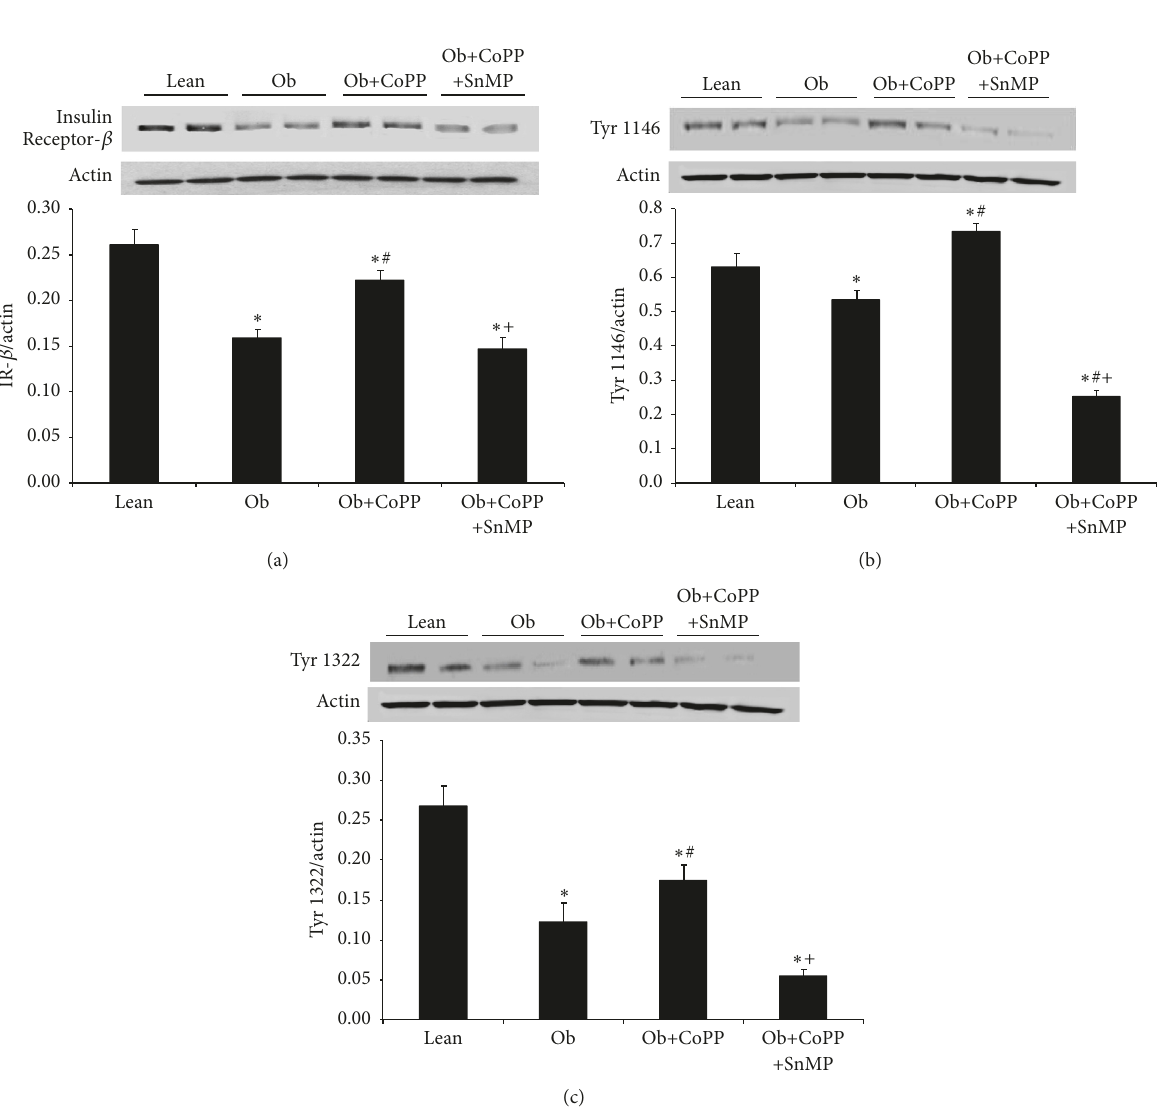
Figure 4: Effect of CoPP and SnMP administration on insulin receptor- 𝛽 , insulin receptor phosphorylated at tyrosine 1146, and insulin receptor phosphorylated at tyrosine 1322 protein levels in liver of lean and obese mice. (a) Total insulin receptor- 𝛽 (IR- 𝛽 ) protein levels, IR- 𝛽 phosphorylation at (b) tyrosine 1146, and (c) tyrosine 1322. Results are mean ± SEM of the bands density normalized to actin. 𝑛 = 3 -4, ∗ 𝑝 < 0.05 versus lean; # 𝑝 < 0.05 versus obese; + 𝑝 < 0.05 versus obese